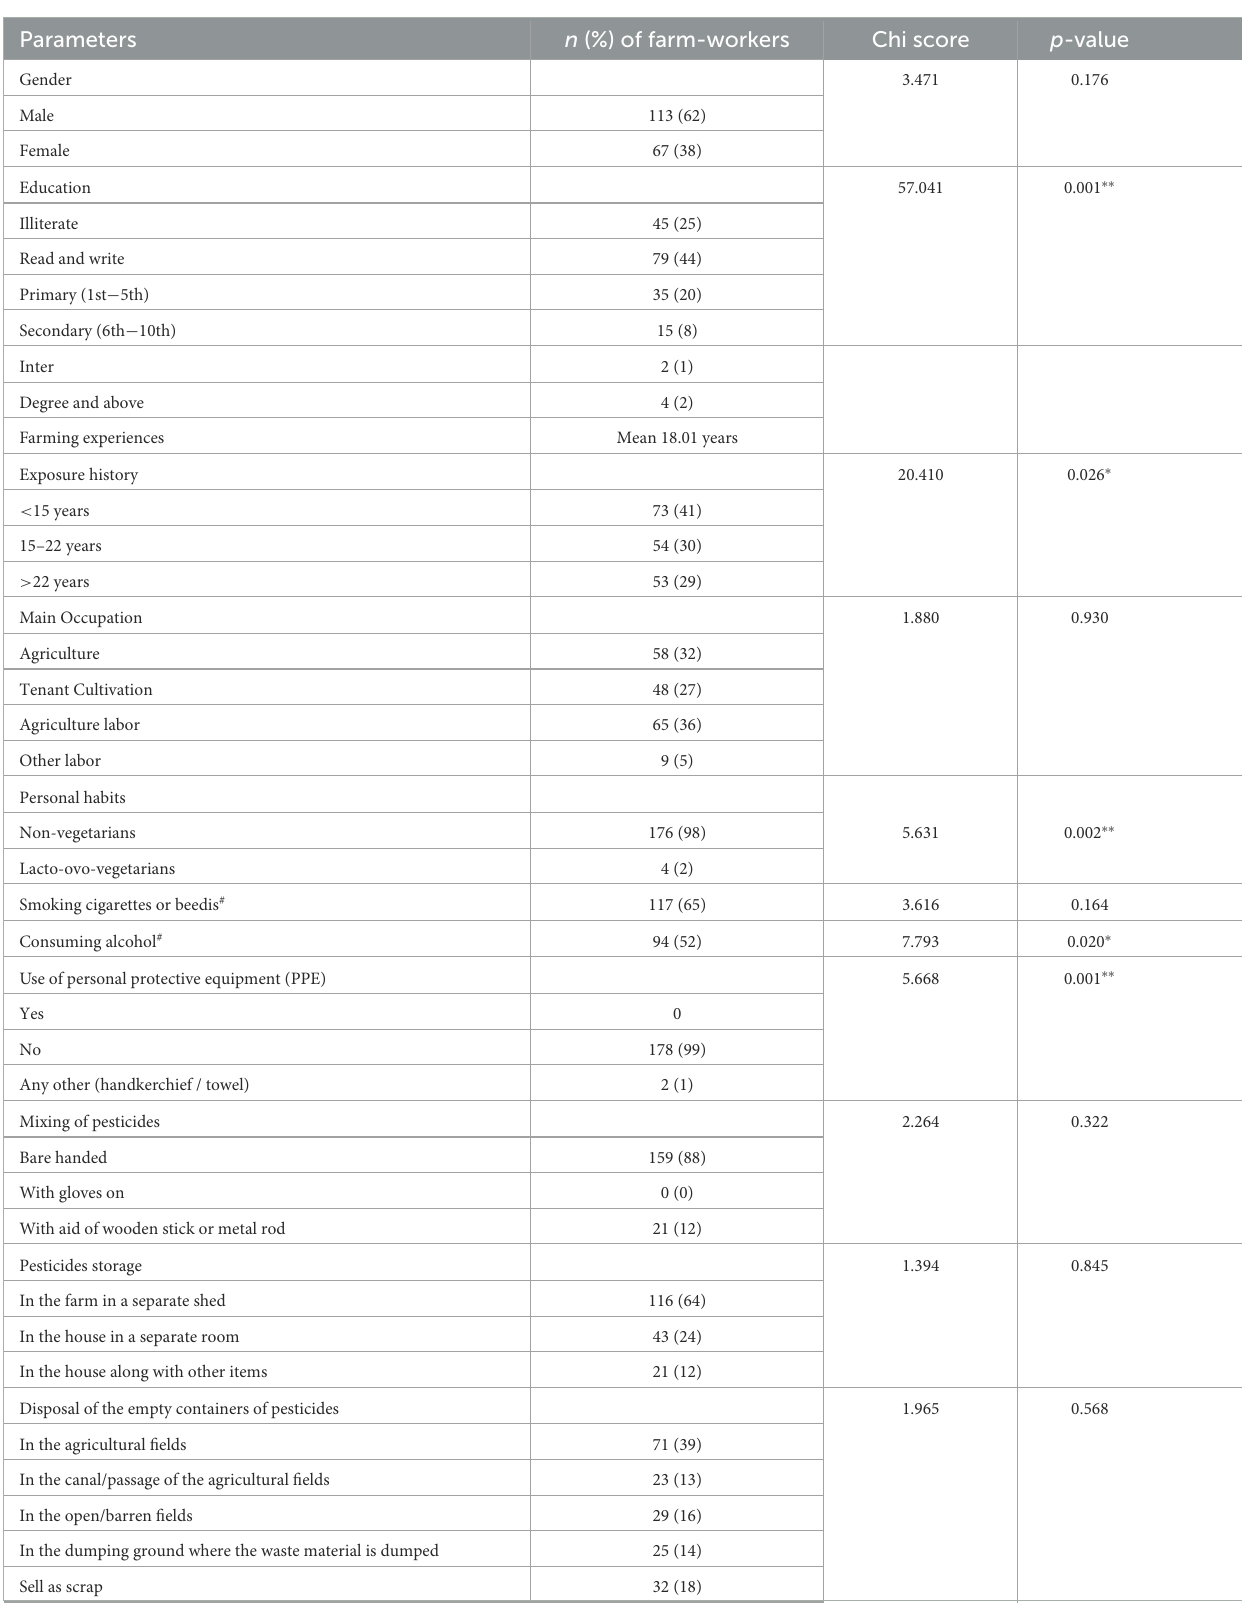
TABLE 2 Basic demographic background pesticide-related awareness, attitude and practice among the surveyed farm-workers ( n = 180).